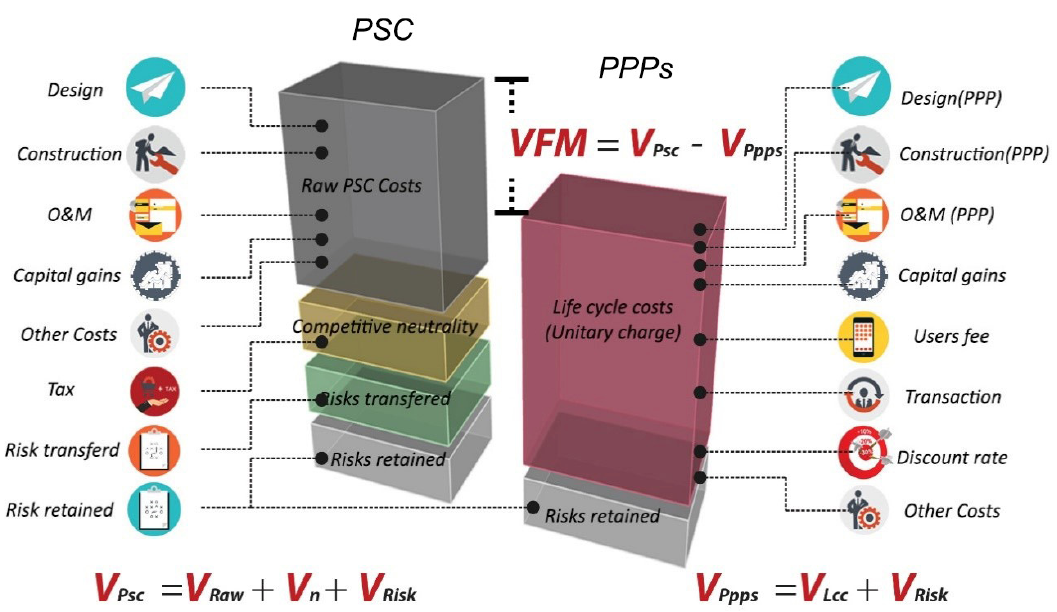
Figure 6. Structure for the quantitative assessment in the VfM process. PSC: public-sector comparator and LCC: lifecycle costs.